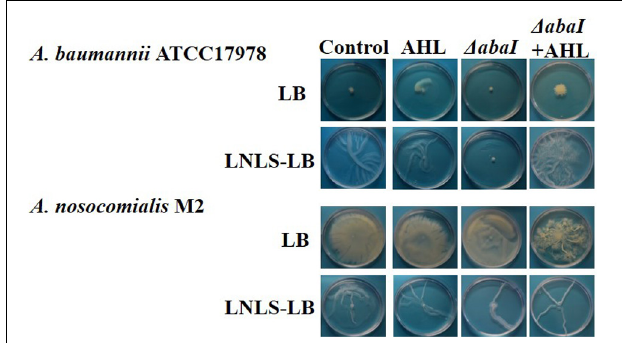
FIGURE 1 | Effect of the mutation of the abaI gene on surface-associated motility of A. baumannii ATCC R (cid:13) 17978 TM , and A. nosocomialis M2. The capacity of OHC12-HSL (10 µ M) to restore the phenotype in the mutants was tested. Plates were prepared in LB or low-nutrient low-salt LB (LNLS-LB) with 0.25% Eiken agar and were incubated at 37 ◦ C for 14 h. Images are representative of three independent experiments carried out with three replicates per condition.